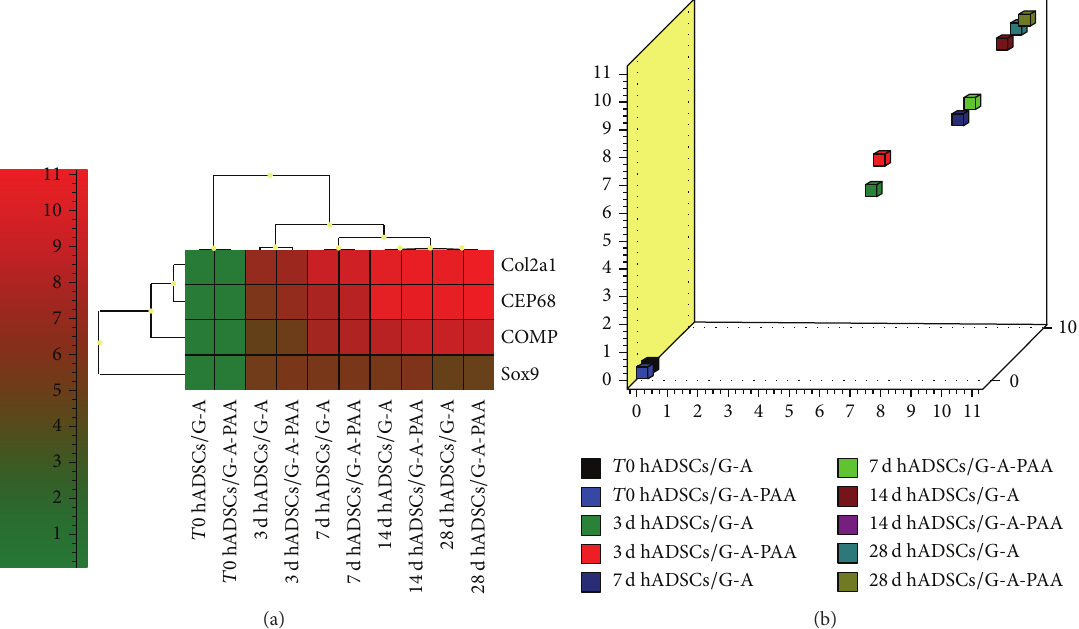
Figure 10: Sox9, Col2a1, CEP68, and COMP chondrogenic markers gene expression analysis via GenEx software generated (a) a heat map and (b) a scatter plot revealing 3D distribution of samples depending on the expression of related ECM markers Col2a1, CEP68, and COMP.